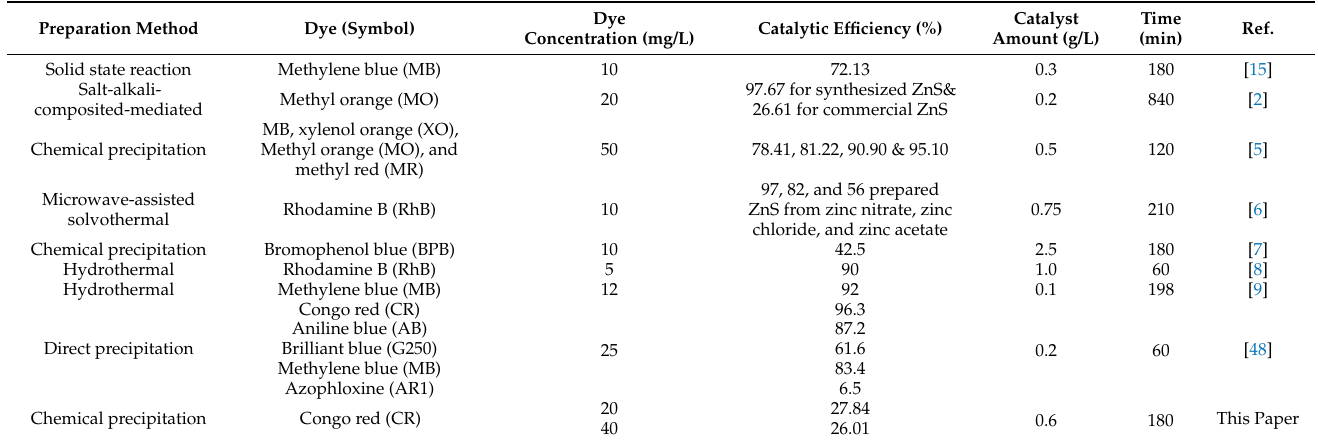
Table 1. The catalytic efficiency of CR dye using ZnS nanoparticles in this study was compared to previously published works on other